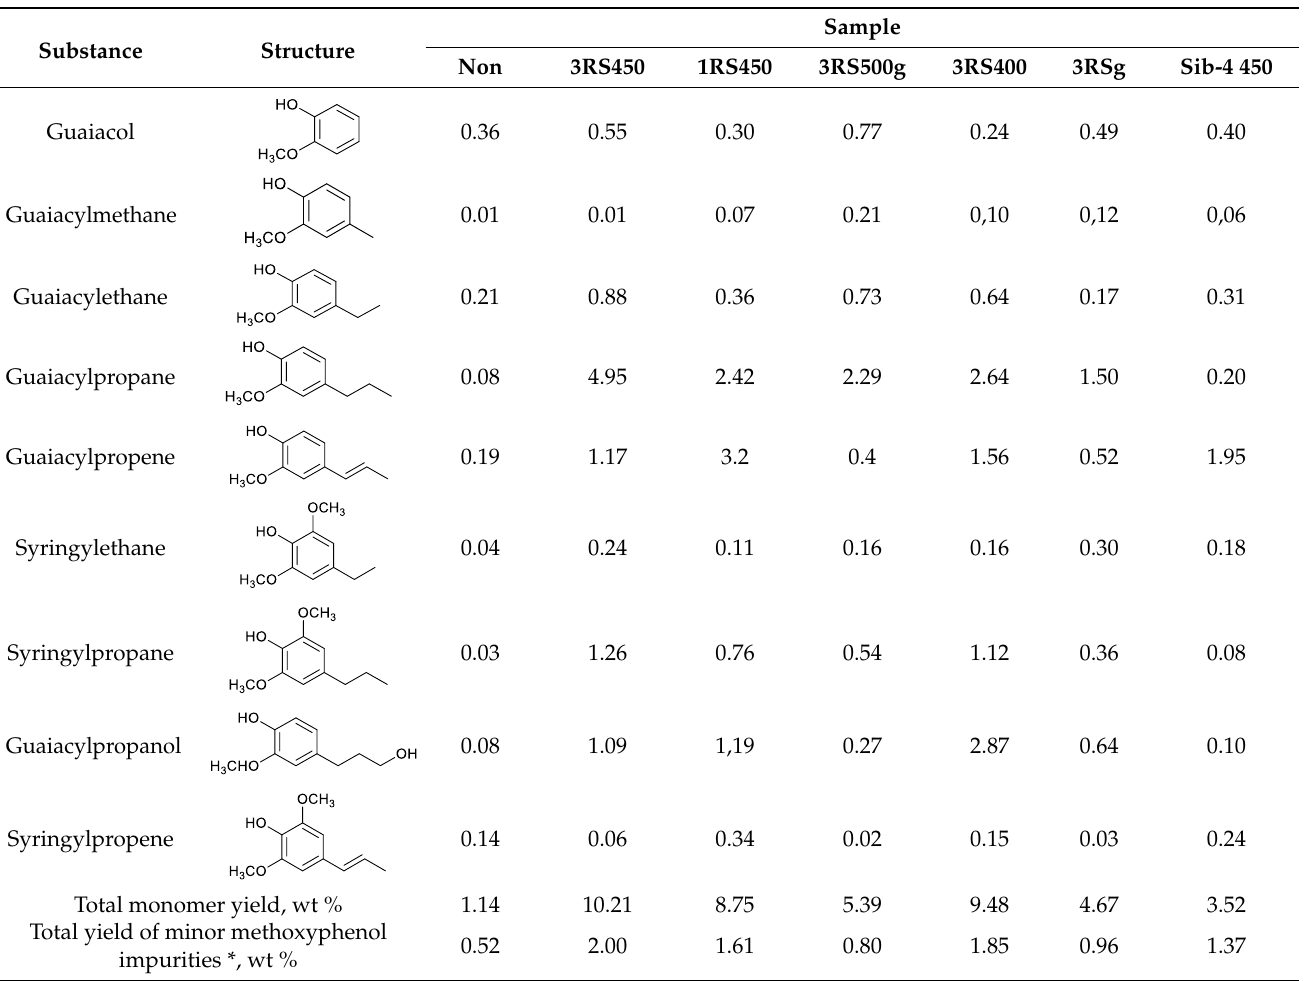
Figure 3. Yields of the methoxyphenols ( 1 ), ( 2 ), ( 3 ) for different catalysts used. Table 8. Yield and composition of monomeric methoxyphenols (wt % per lignin) in the liquid products of noncatalytic and catalytic hydrogenation of flax shive in subcritical ethanol at 225 ◦ C.